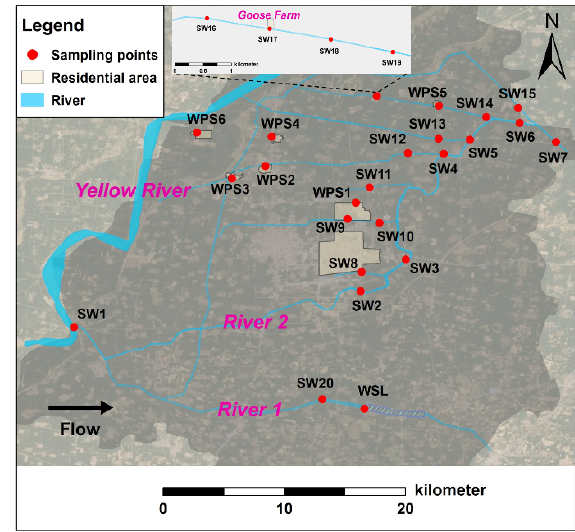
Figure 1. Map of the study area. Table 1. Sampling sites in the selected study